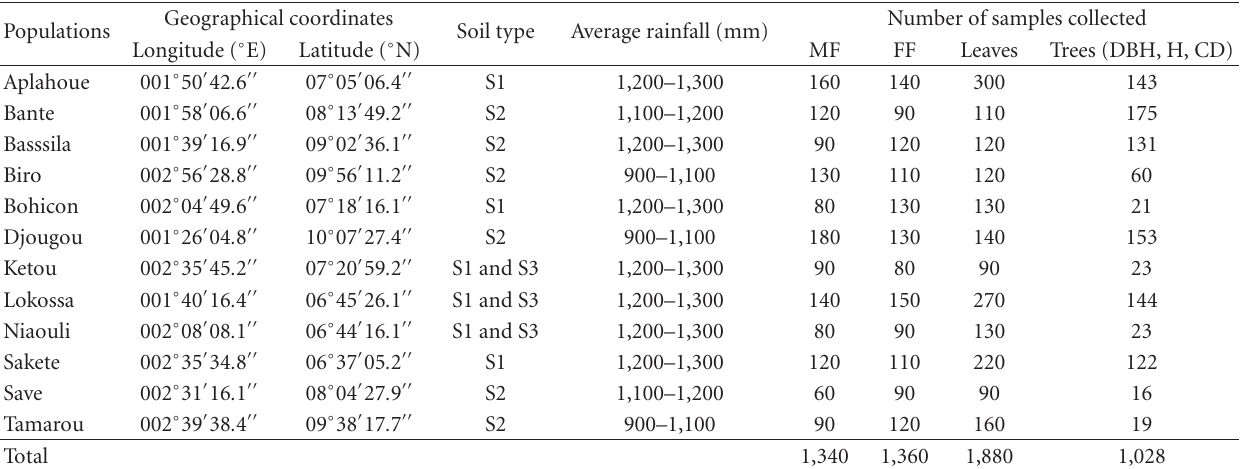
Table 1: Sample-size geographical locations and ecological characteristics of iroko populations sites. Geographical coordinates Populations